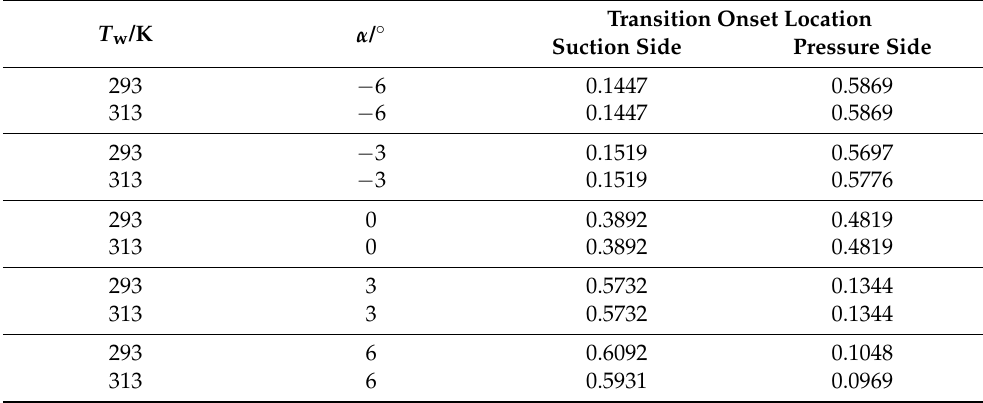
Table A3. Influence of surface temperature on transition onset location ( ε = 0.5%, Ma =